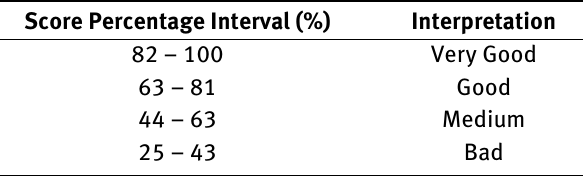
Table 3: Qualitative criteria for learning implementation